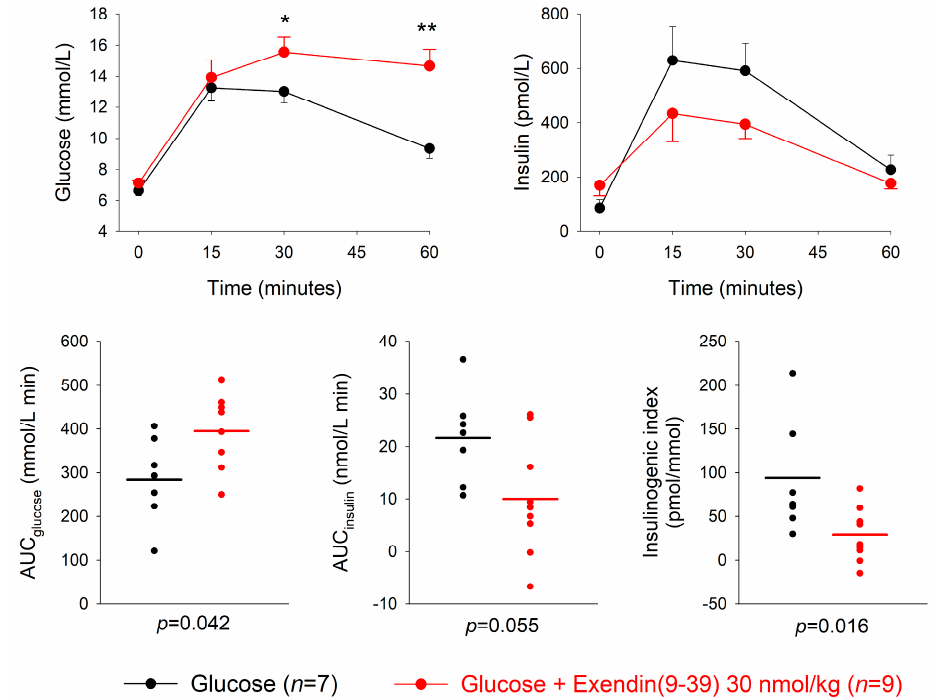
Figure 2. Glucose and insulin levels, and individual data points for AUC glucose , AUC insulin and insulinogenic index after intravenous administration of the GLP-1 receptor antagonist exendin(9-39) (30 nmol/kg) or saline four minutes after oral administration of 50 mg glucose in normal mice. Means ± SEM are shown. Asterisks indicate the probability level of random difference between exendin(9-39) versus glucose control; * p < 0.05; ** p < 0.01; exact p levels see results section; n indicates number of animals.